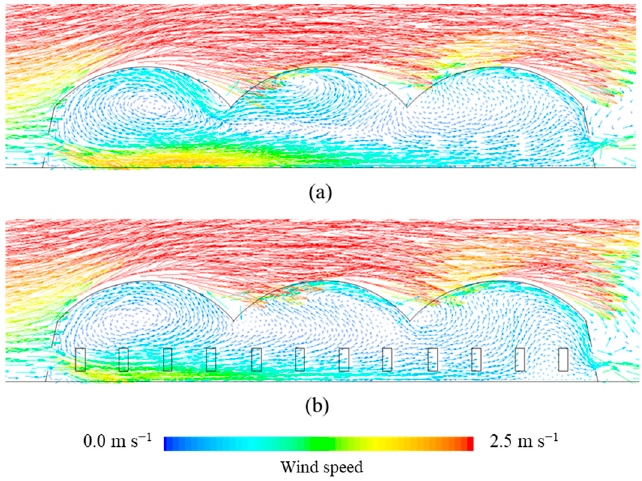
Figure 11. Distribution of the WS of the greenhouse (side view) ( a ) without tomatoes and ( b ) with tomatoes (WS: 3.0 m s − 1 , WD: 90°, and crop height: 1.0 m). tomatoes (WS: 3.0 m s − 1 , WD: 90 ◦ , and crop height: 1.0